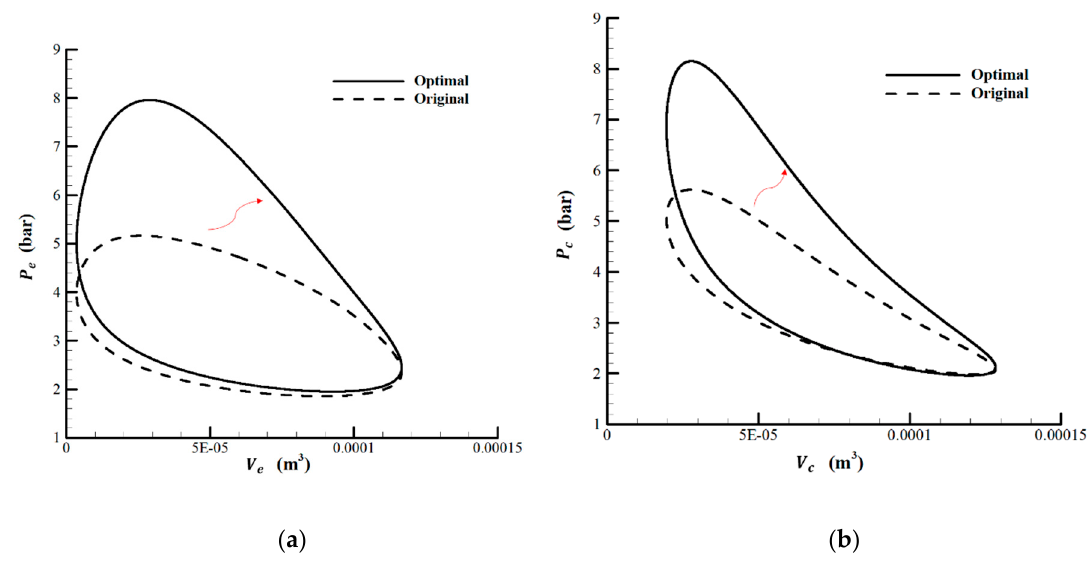
Figure 9. Minimization of objective function in the optimization process.